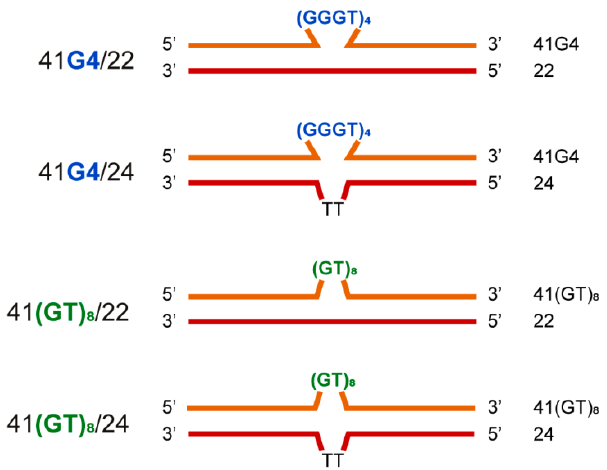
Figure 4. DNA models used for spectroscopic studies. DNA sequences are presented in the Supplementary Materials. The names of DNA duplexes are shown on the left, and the names of the single-stranded oligonucleotides are given on the right.